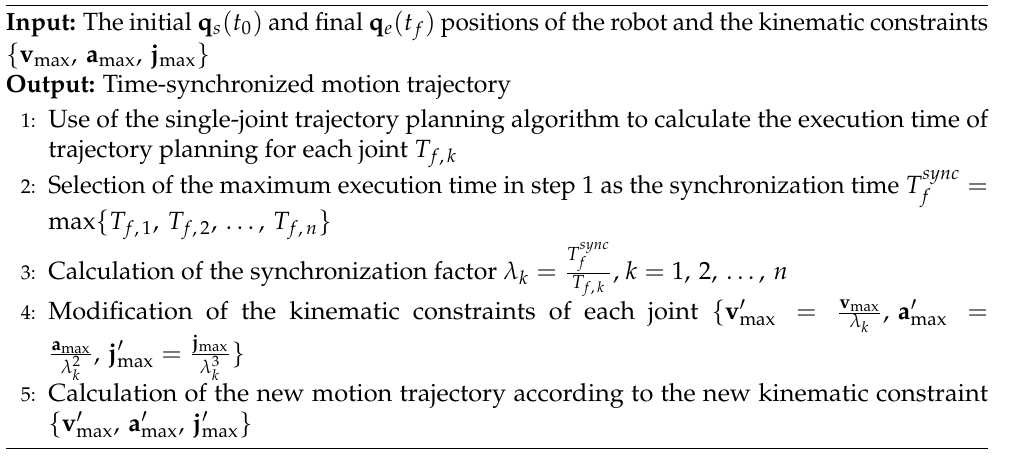
Algorithm 1 Trajectory planning algorithm for multi-axis synchronization